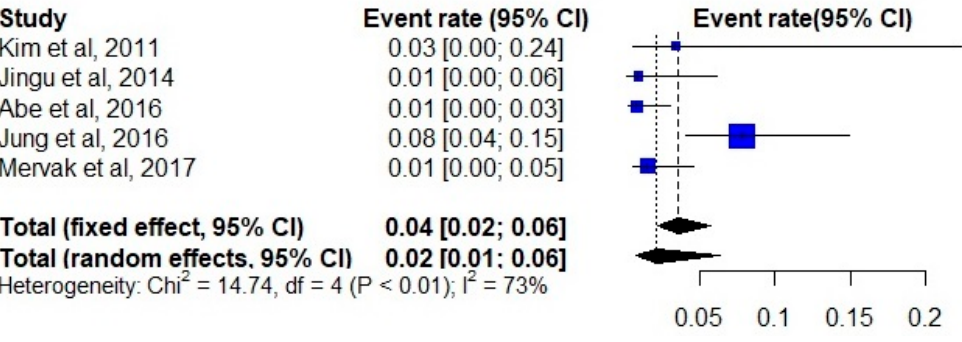
Figure 3. Forest plot of the event rate of hypersensitivity reactions in premedicated patients. [29,26,30,28,27].